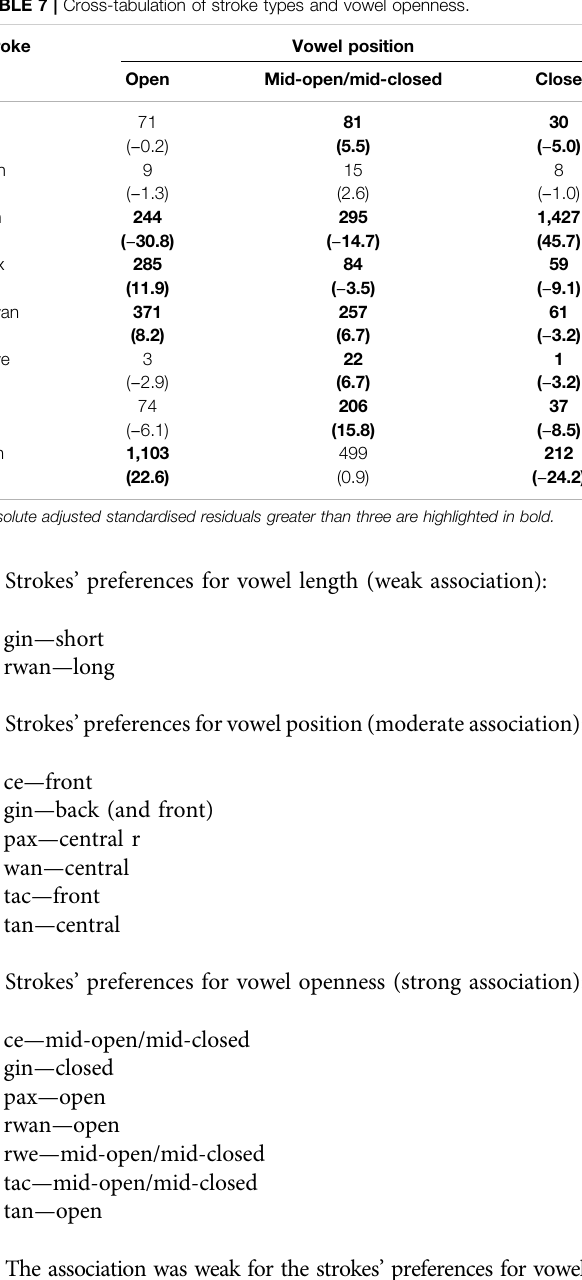
TABLE 7 | Cross-tabulation of stroke types and vowel openness. Stroke Vowel position